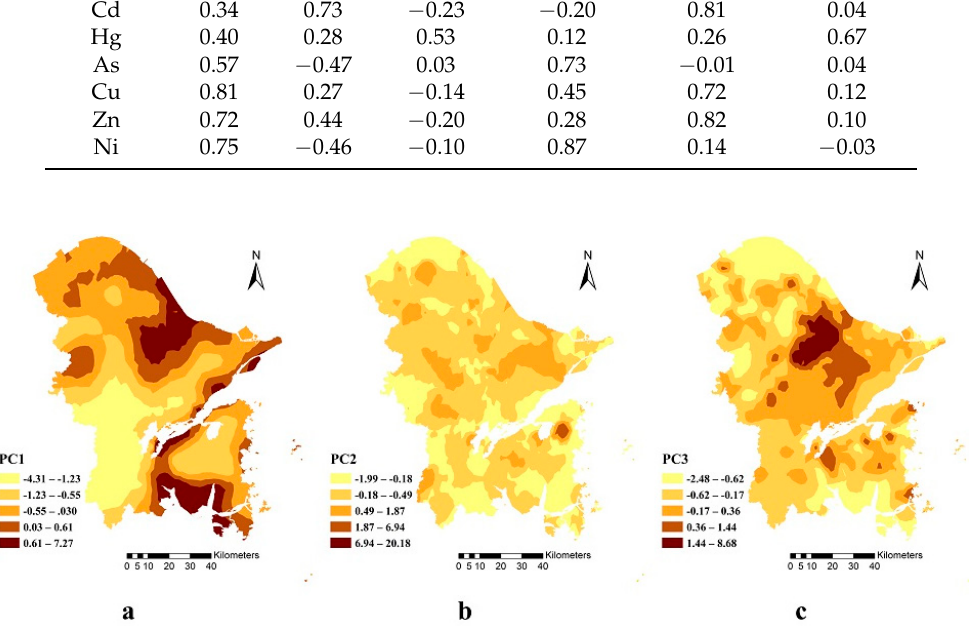
Figure 6. OK interpolation maps of ( a ) PC1; ( b ) PC2; ( c ) PC3.